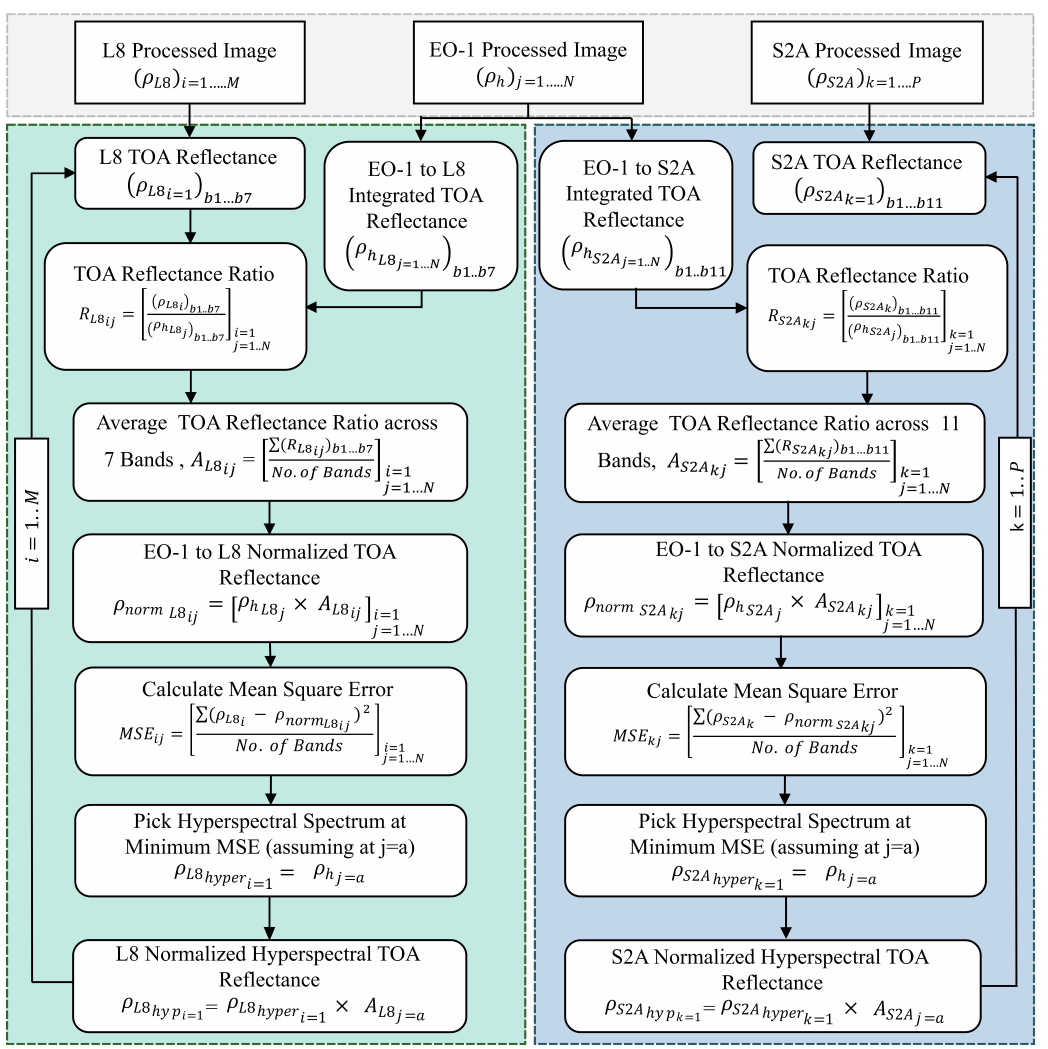
Figure 8. Overall flowchart showing the Dark Hyperspectral Dataset generation process.